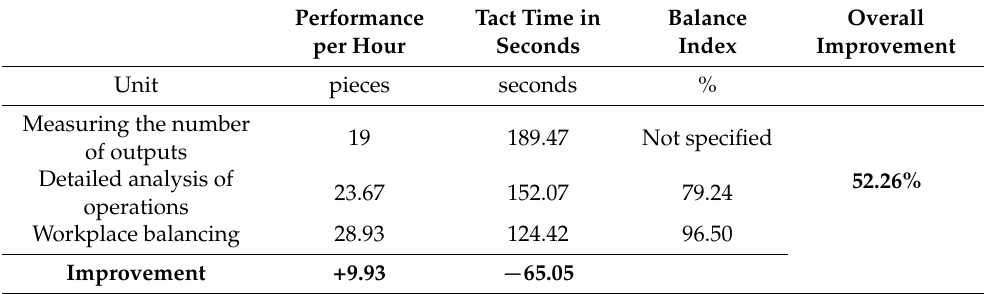
Table 9. Comparison of results based on the chosen approach of production